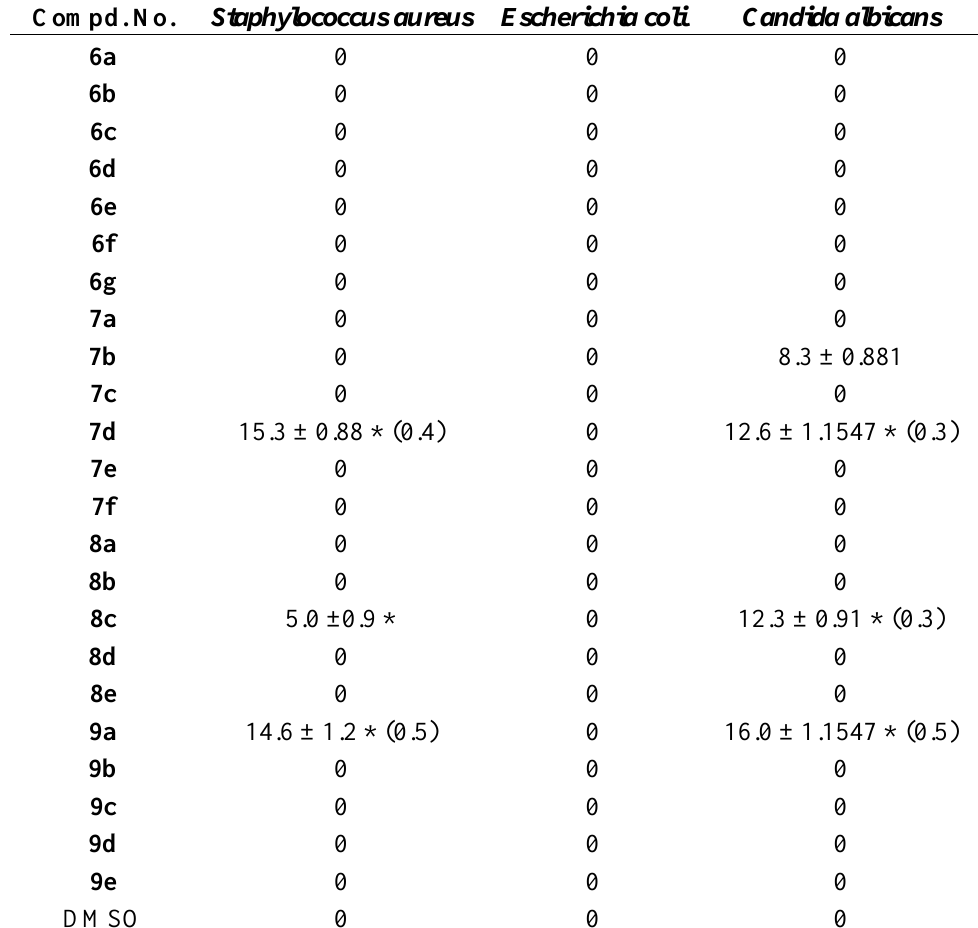
Table 1. Detection of the antimicrobial activity of some organic compounds by measuring the formed inhibition zone (inhibition zone measured in mm and MIC in